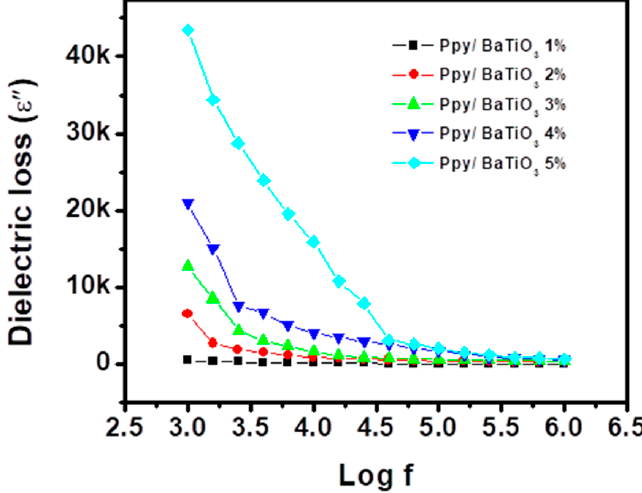
Figure 12. Variation of dielectric loss with frequency for PPy/BaTiO 3 composites.